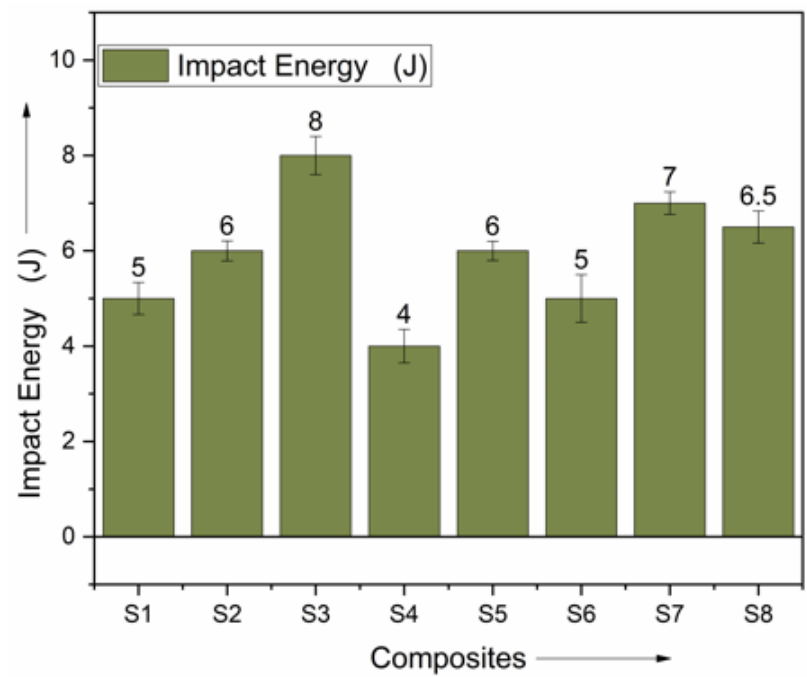
Figure 12. Comparison of impact energy.